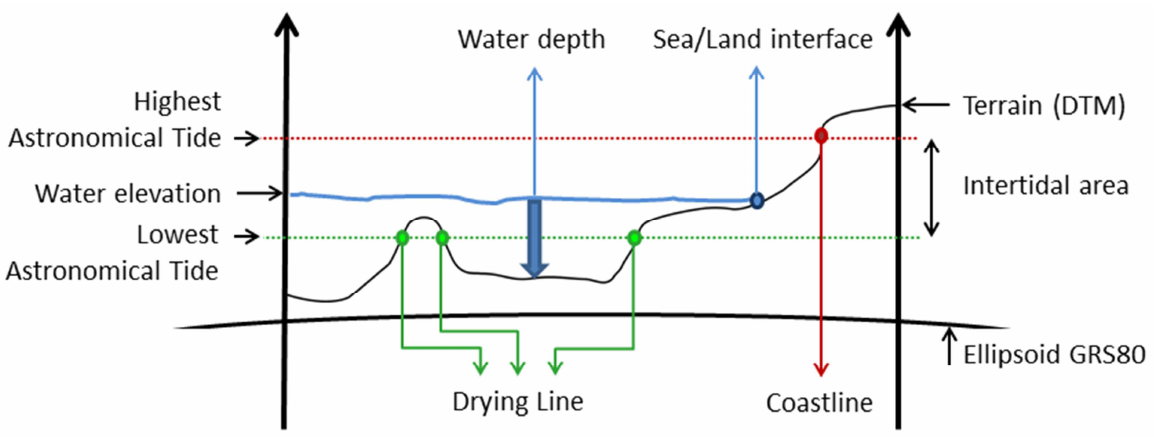
Figure 1: Illustration of the intertidal area, between the drying line and the coastline.